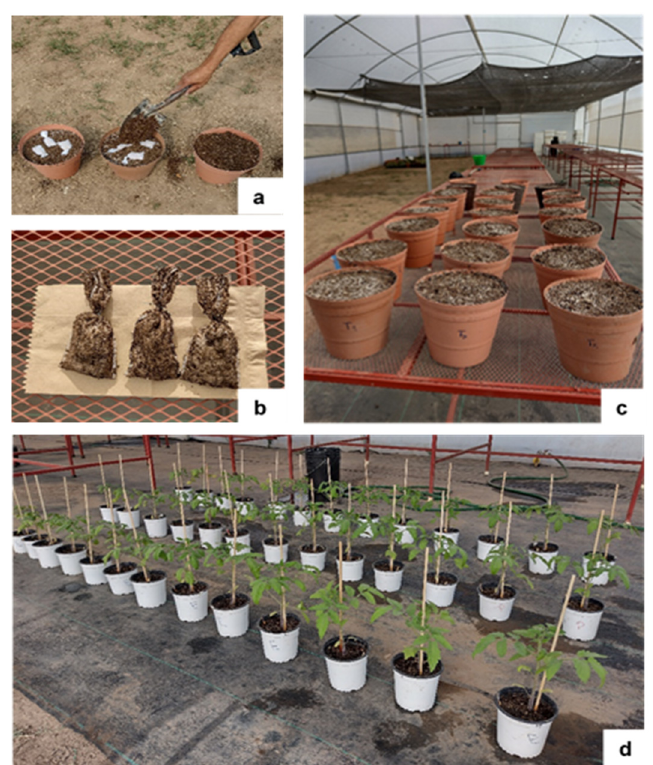
Figure 6. Decomposition in soil of Ulva ohnoi . ( a ) Three litter litterbags (1.0 mm openings) with fragmented dried seaweed were placed 5 cm deep into each pot, ( b ) the collected litterbag sampling days at 7, 14, 21, 28, 35, 42, 49, and 56 d after the start of the experiment, ( c ) image of the pots and the litterbag method in the greenhouse and ( d ) arrangement of experimental units in the plant growth at 45-days-old.